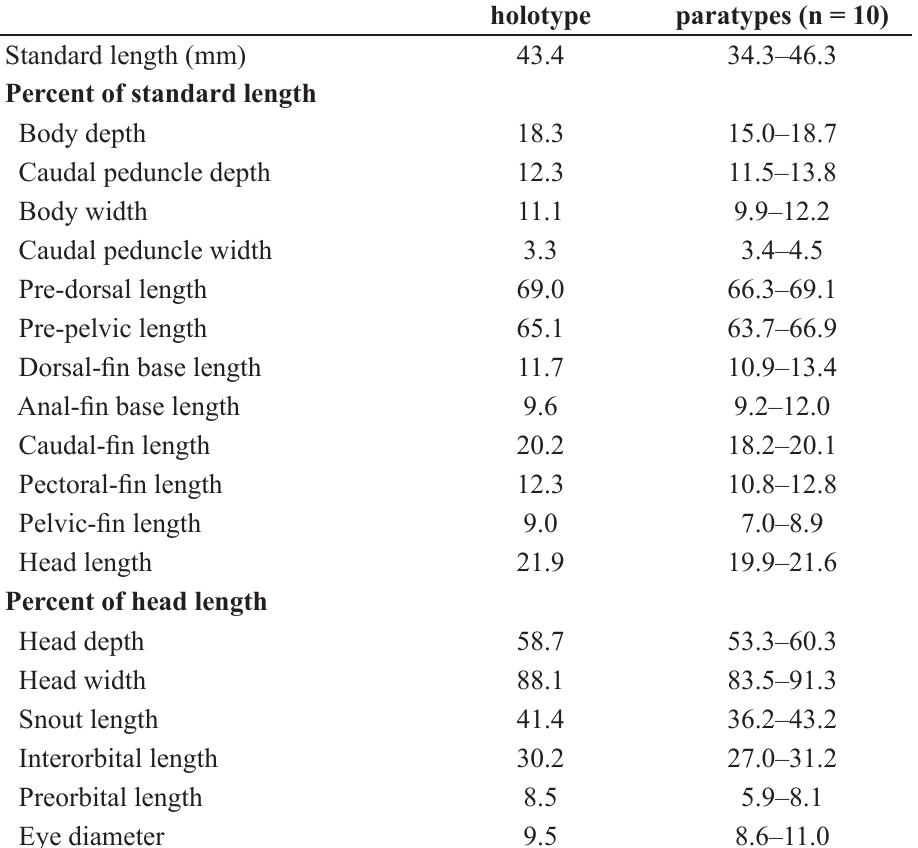
Table 1. Morphometric data for Cambeva alphabelardense sp.